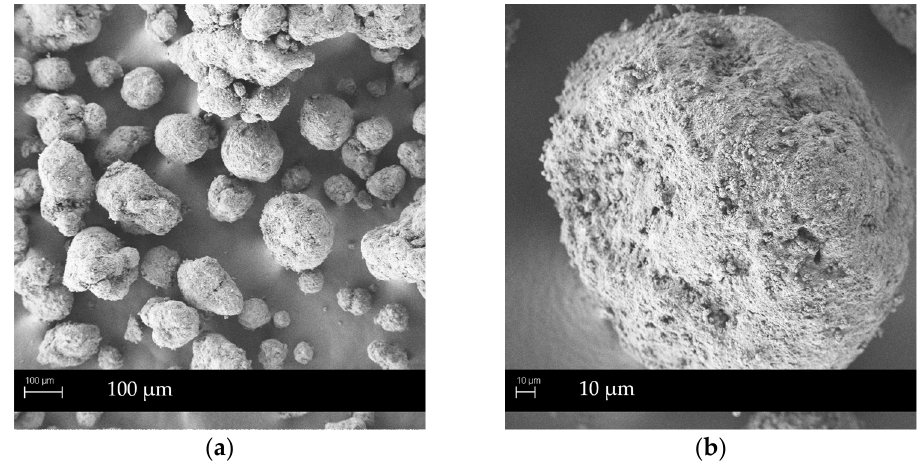
Figure 3. SEM images of G hs NEU: ( a ) under magnification 200×; ( b ) under magnification 1000×.